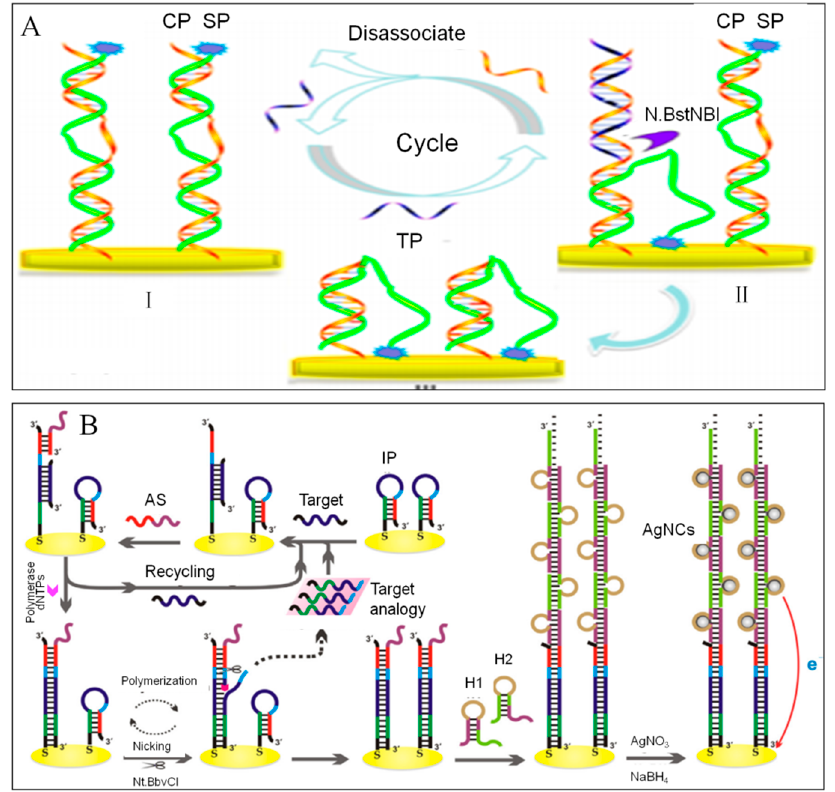
Figure 11. ( A ) An electrochemical DNA biosensor to investigate 16S rDNA of Bacillus subtilis based on SDA [119, 145]. Copyright 2014. Reproduced with permission from American Chemical Society. ( B ) A label-free and ultrasensitive electrochemical DNA biosensor based on the cascade ASDA and HCR strategy [161]. Copyright 2018. Reproduced with permission from Elsevier